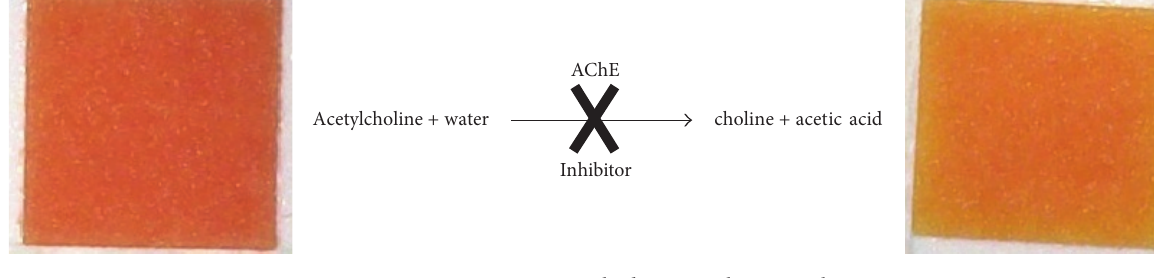
Figure 2: pH sensitive method using AChE principle.